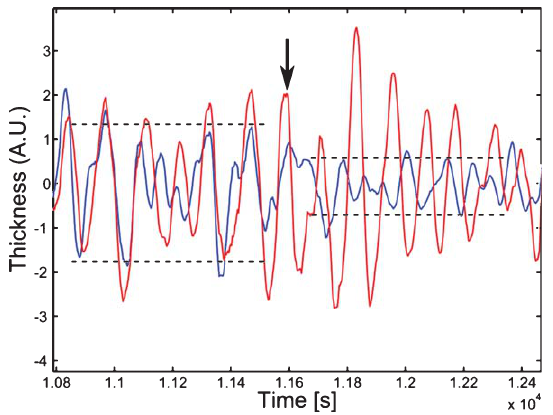
Fig. 5. A typical reaction of the Physarum plasmodium to light stimulus. Only one of two wells is exposed to white light (blue curve). A LED light is turned on at the point indicated by a down- ward arrow and kept on till the end of the plot. The oscillation period of the stimulated well (blue curve) becomes slightly longer when the light is on, whereas that of the unstimulated well (red curve) remains unchanged. The oscillation amplitude significantly decreases in the stimulated well and increases in the other well (hor- izontallines).(Coloursarevisibleintheonlineversionofthearticle; http://dx.doi.org/10.3233/ABB-2012-0059)